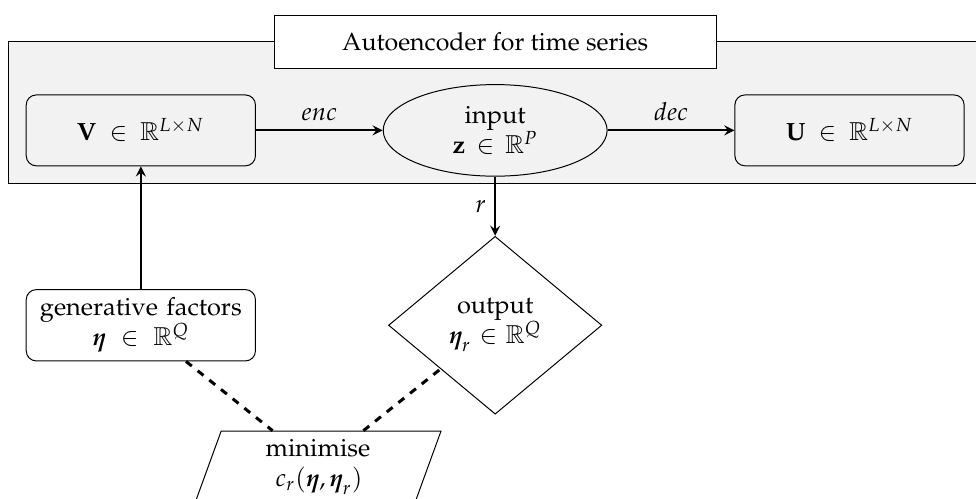
Figure 4. Schematic representation of the regression between z and η , wherein the loss function ) is computed via Equation (2). For the enc and dec architectures, see again Figures 1 and 2. c r ( η , η r For the r architecture, see Figure 5.